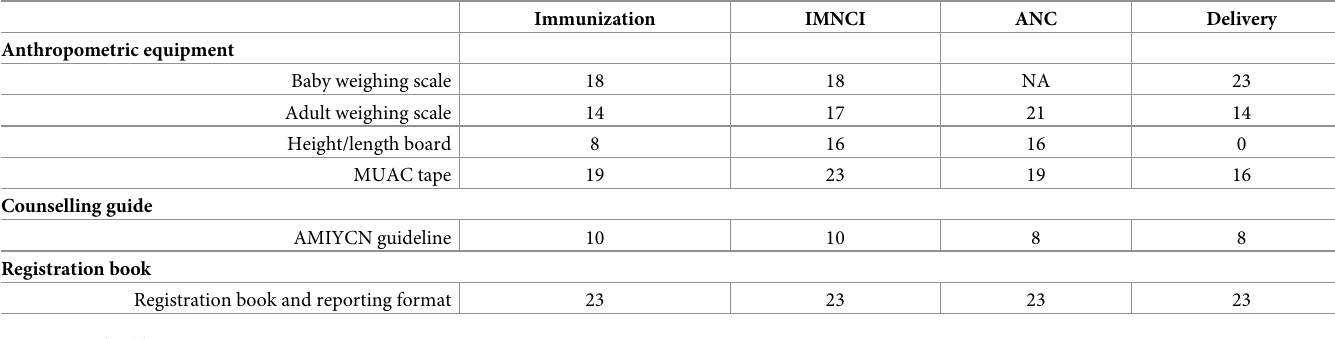
Table 1. Availability of equipment, guidelines and record keeping registers at health centers (n =